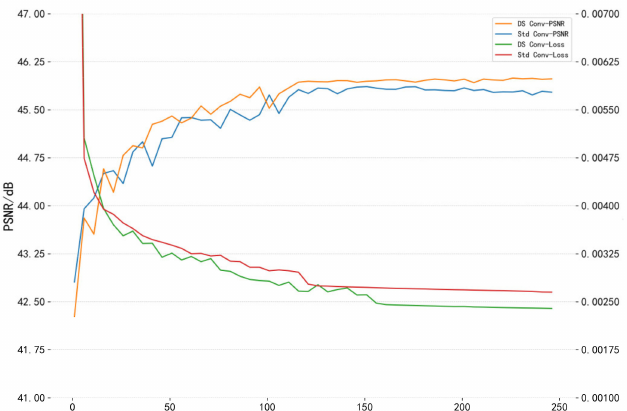
Figure 12. The network loss of the same structure model with different convolution types on the CAVE dataset and the PSNR value change process of the test set. The data sampling interval is once every five